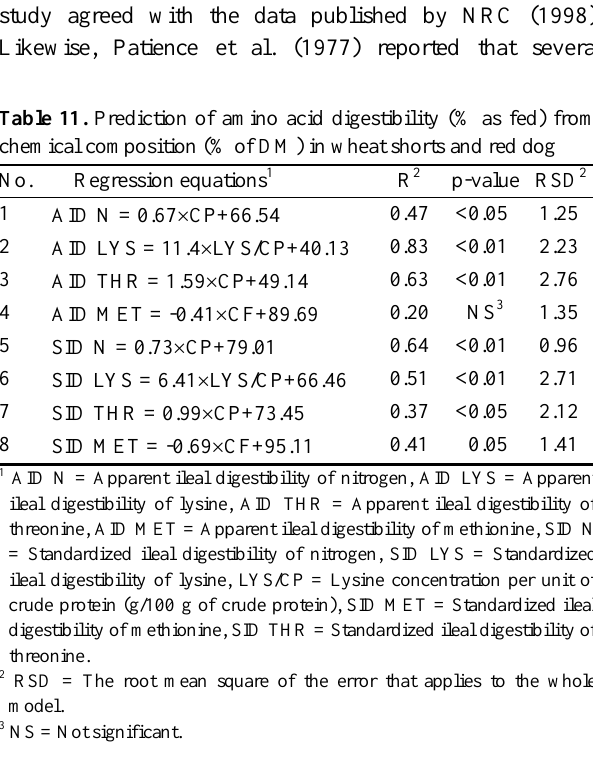
= Gansu, SC = Sichuan, HEN = He’nan, SD = Shandong, HUB = Hubei). Values are means for 6 observations. 2 CV = Coefficient of variation. 3 p-value: Overall = Comparisons among 10 wheat shorts and red dog. WS vs RD = Comparison of the wheat shorts and red dog